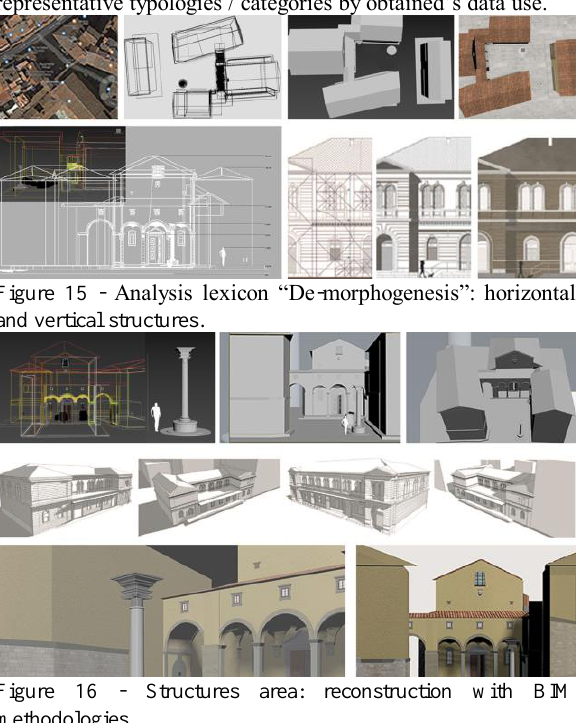
Figure 16 - Structures area: reconstruction with BIM methodologies.